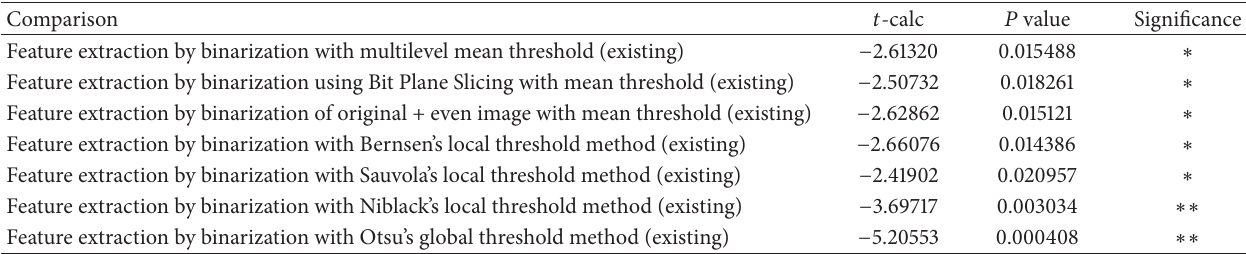
Table 8: Univariate 𝑡 test.